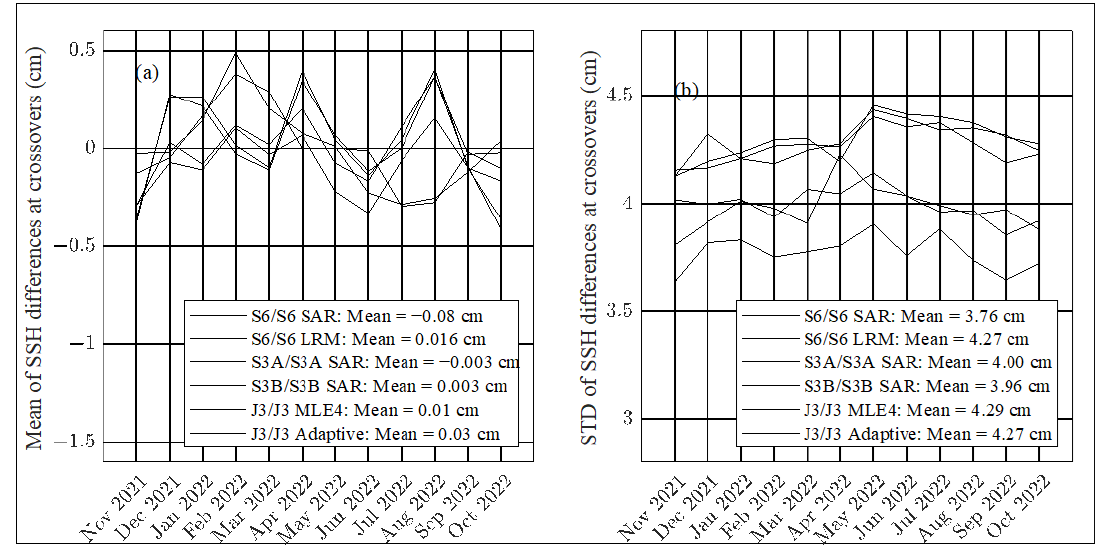
Figure 5. Month per month monitoring of ( a ) mean and ( b ) STD of SSH crossover differences for Sentinel-6, Sentinel-3A/B and